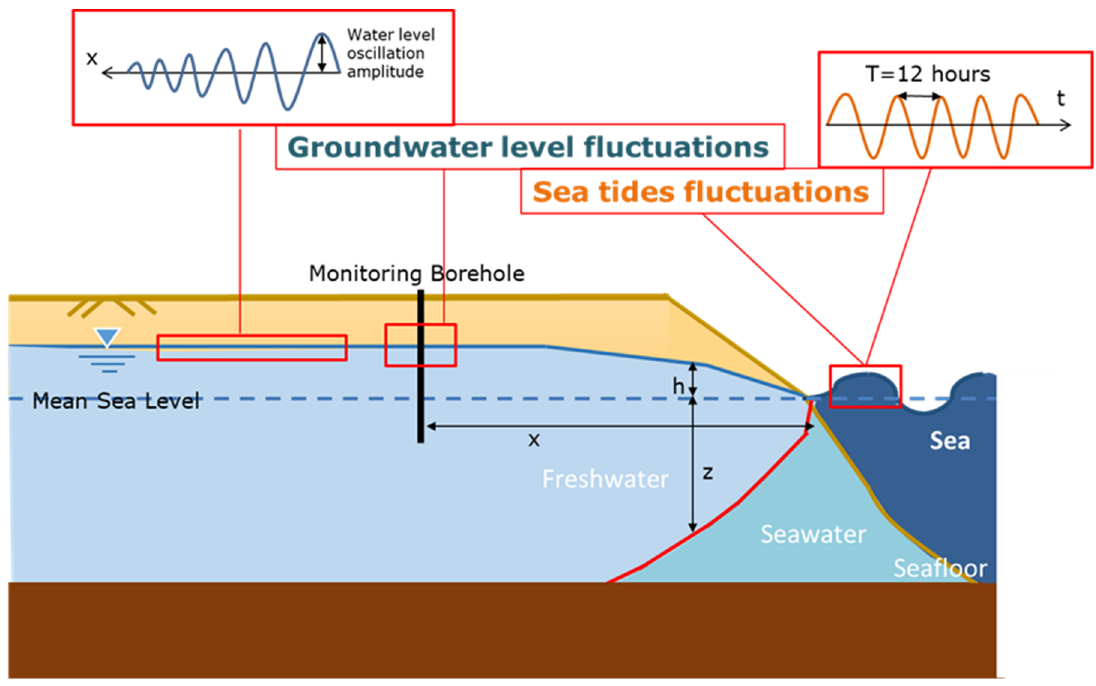
Figure 1. Conceptual diagram of tidally-induced groundwater level signals over space and tide fluctuation over time in a schematic coastal aquifer, where x is the distance of the monitoring borehole from the coastline, h is the hydraulic head, z is the depth of the freshwater/seawater interface from mean sea level, and T is the period of the wave length.